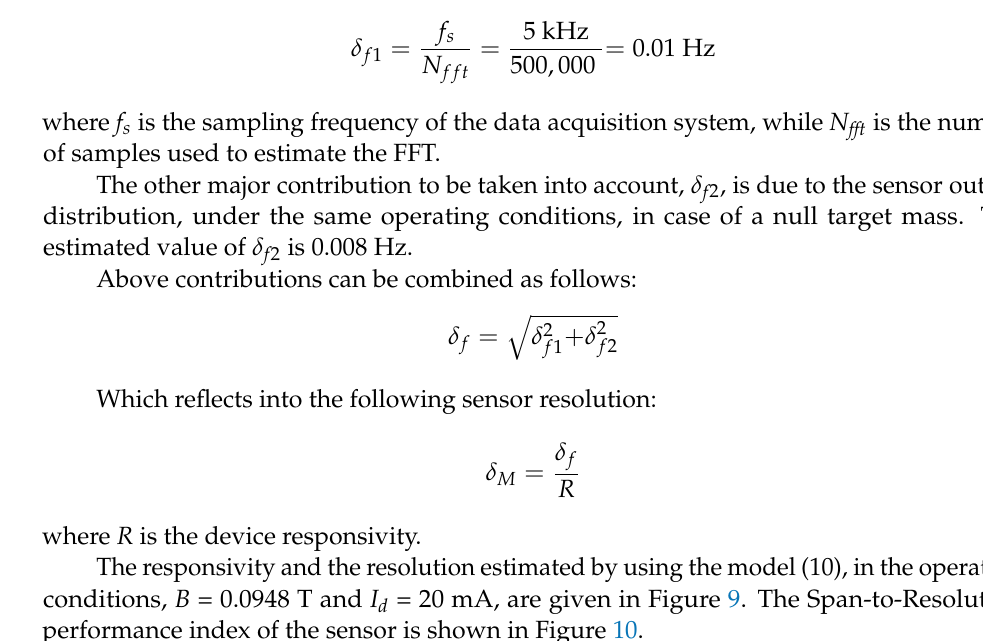
Figure 10. Span-to-Resolution of the mass sensor estimated in the following operating conditions: B = 0.0948 T and I d = 20 mA.